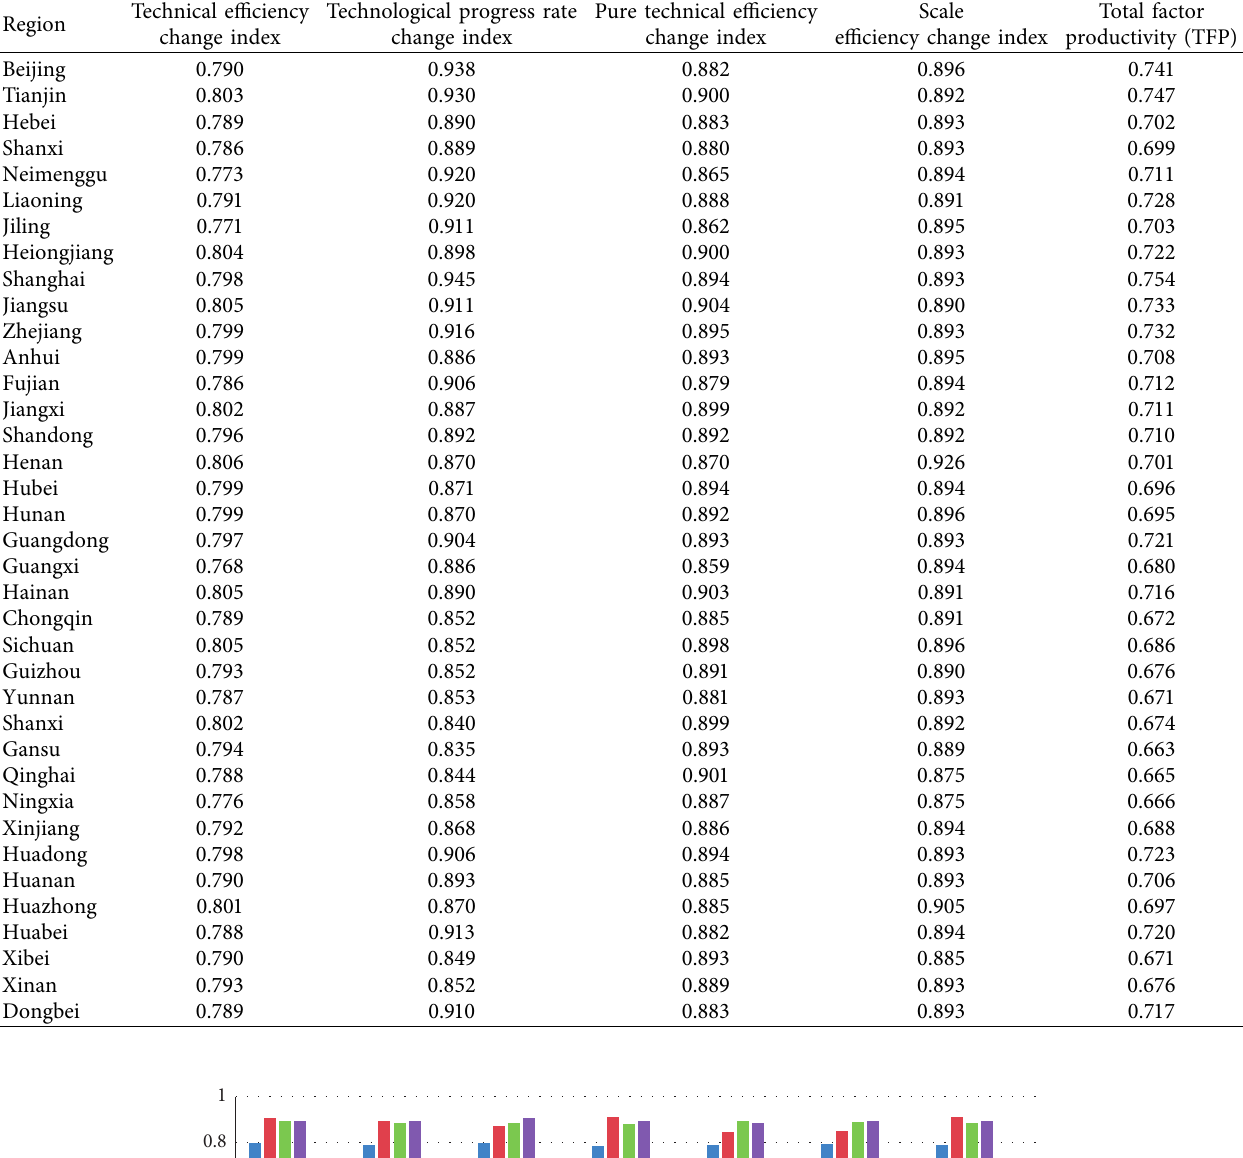
Table 2: 2001–2017 national cumulative total factor productivity index and its